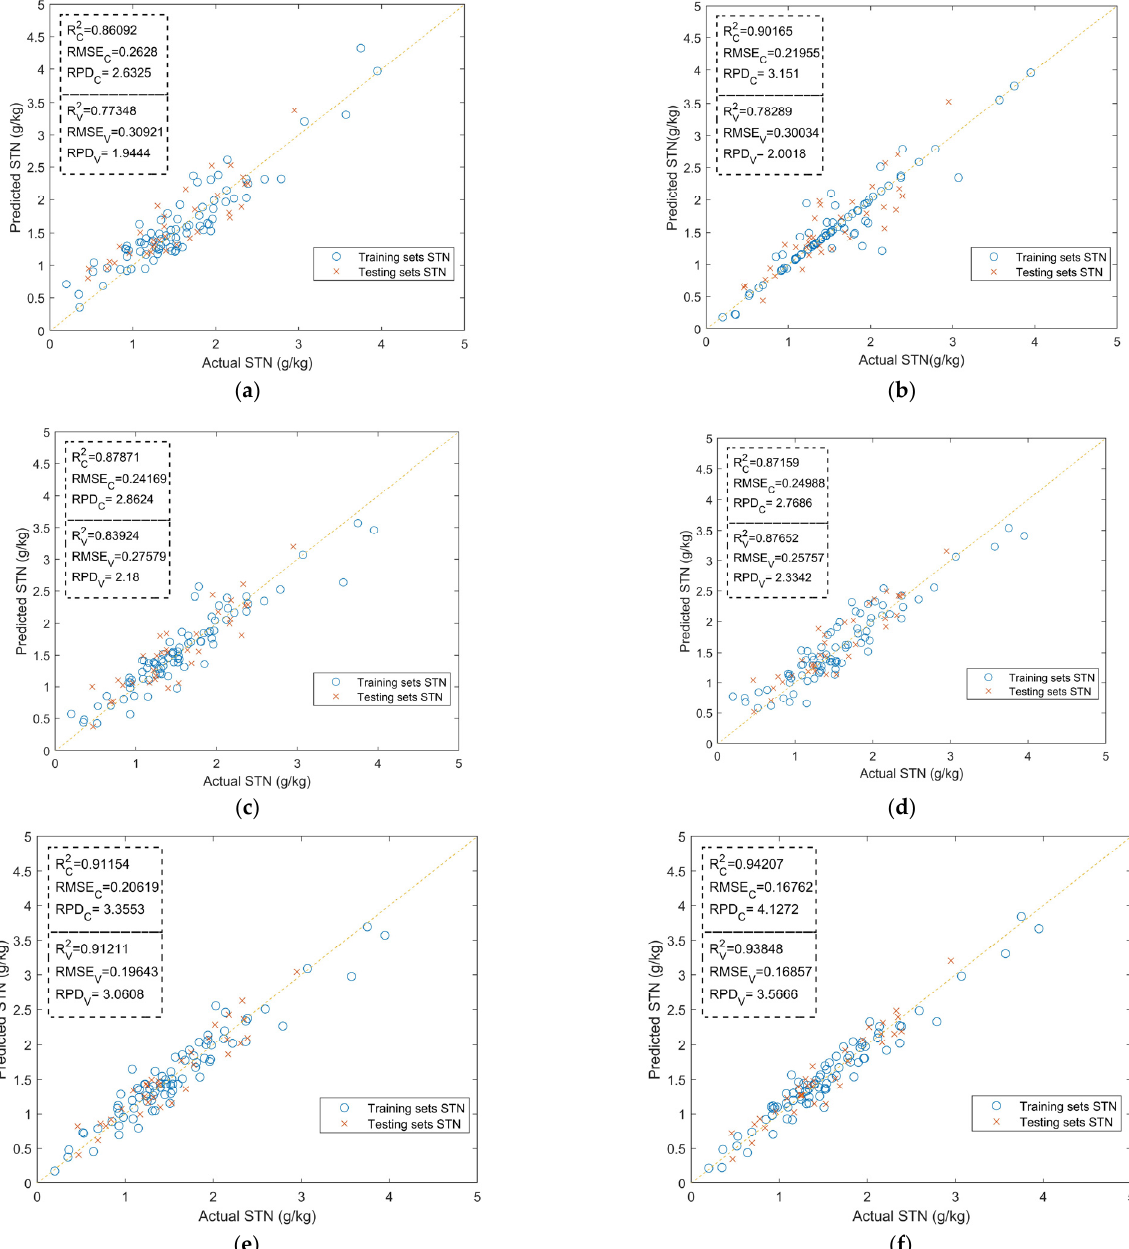
Figure 10. Results of three models after optimization of PCA and GA-BP features. ( a ) Prediction results of BPNN model after PCA optimization. ( b ) GA-BP optimized BPNN model prediction results. ( c ) Prediction results of ELM model after PCA optimization. ( d ) Prediction results of ELM model after GA-BP optimization. ( e ) Prediction results of PLSR model after PCA optimization. ( f ) Prediction results of PLSR model after GA-BP optimization.